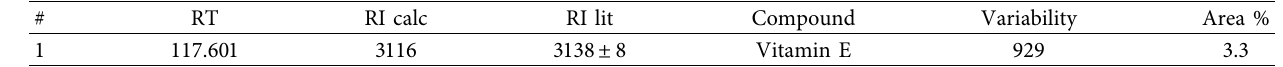
Table 2: Results of chromatographic analysis.